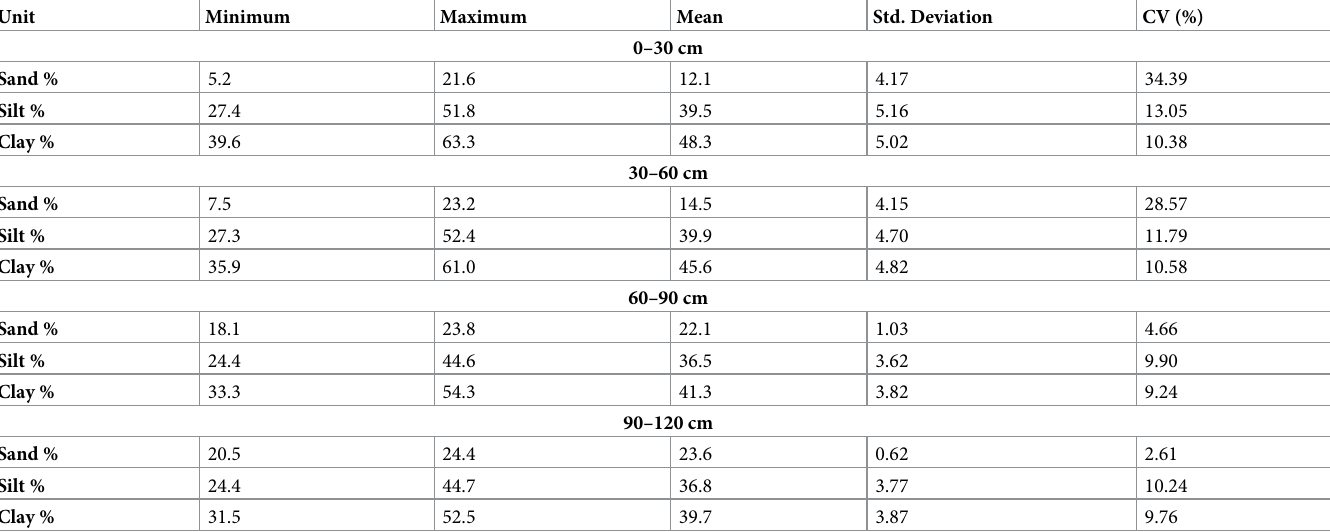
Table 2. Particle size distribution of soil samples in the study area.